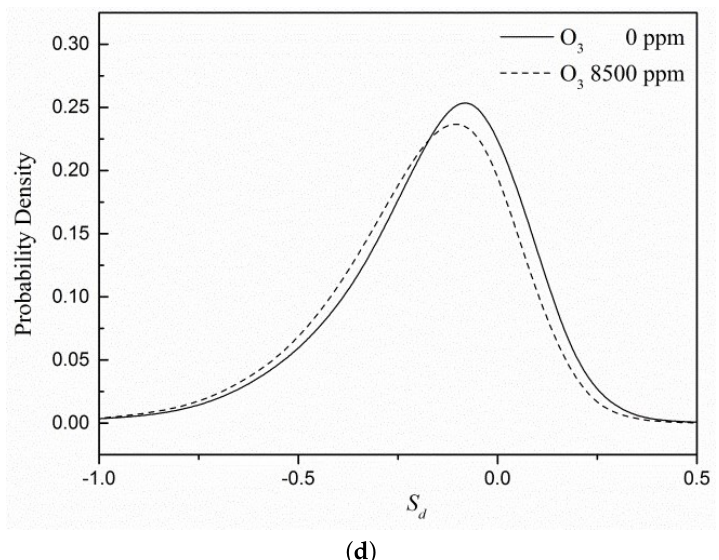
Figure 7. Probability density distribution of statistics on the flame surface. ( a ) Tangential strain rate, ( b ) curvature, ( c ) the effective radius of flame curvature, and ( d ) the displacement speed of the flame